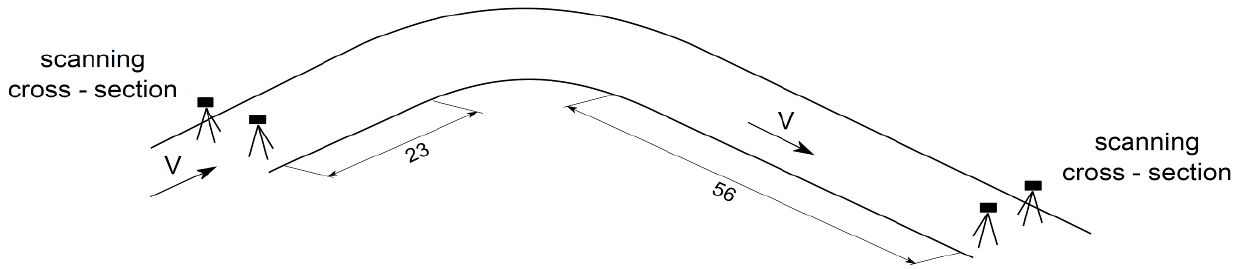
Figure 2. Explored section of the mining tunnel.